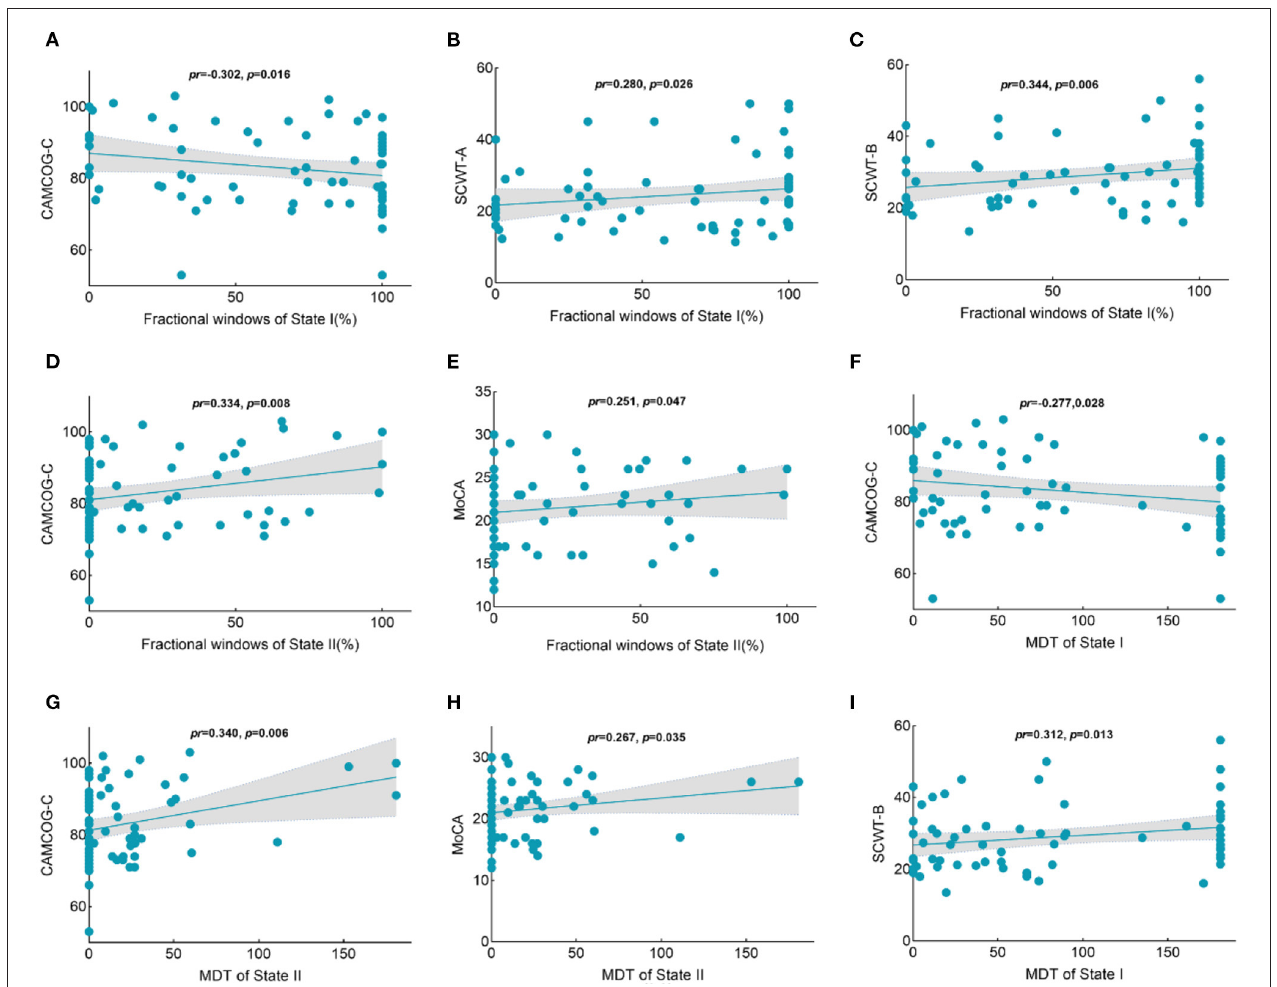
FIGURE 7 | Correlations between the temporal properties with intergroup differences and the cognition scores in the CSVD group. (A) A negative relationship was observed between the percentage of state I and the CAMCOG-C scores. (B) A positive relationship was observed between the percentage of state I and time consumption in SCWT-A performances. (C) A positive relationship was observed between the percentage of state I and time consumption in SCWT-B performances. (D) A positive relationship was observed between the percentage of state II and the CAMCOG-C scores. (E) A positive relationship was observed between the percentage of state II and MoCA scores. (F) A negative relationship was observed between the MDT in state I and CAMCOG-C scores. (G) A positive relationship was observed between the MDT in state I and time consumption in SCWT-B performances. (H) A positive relationship was observed between the MDT in state II and CAMCOG-C scores. (I) A positive relationship was observed between the MDT in state II and MoCA scores. CAMCOG-C, Cambridge Cognitive Examination–Chinese version; SCWT, Stroop Color-Word test; MoCA, Montreal Cognitive Assessment; MDT, mean dwell